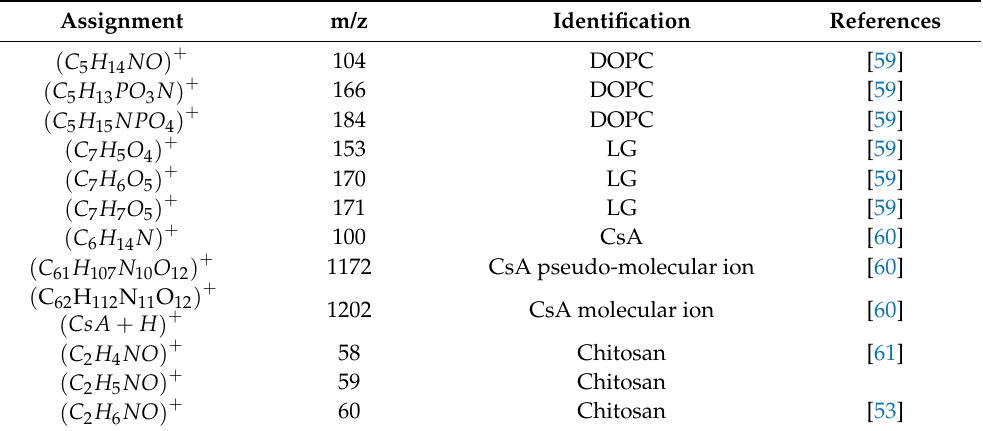
Table 4. The most characteristic positive fragments in the TOF-SIMS mass spectra obtained for all examined